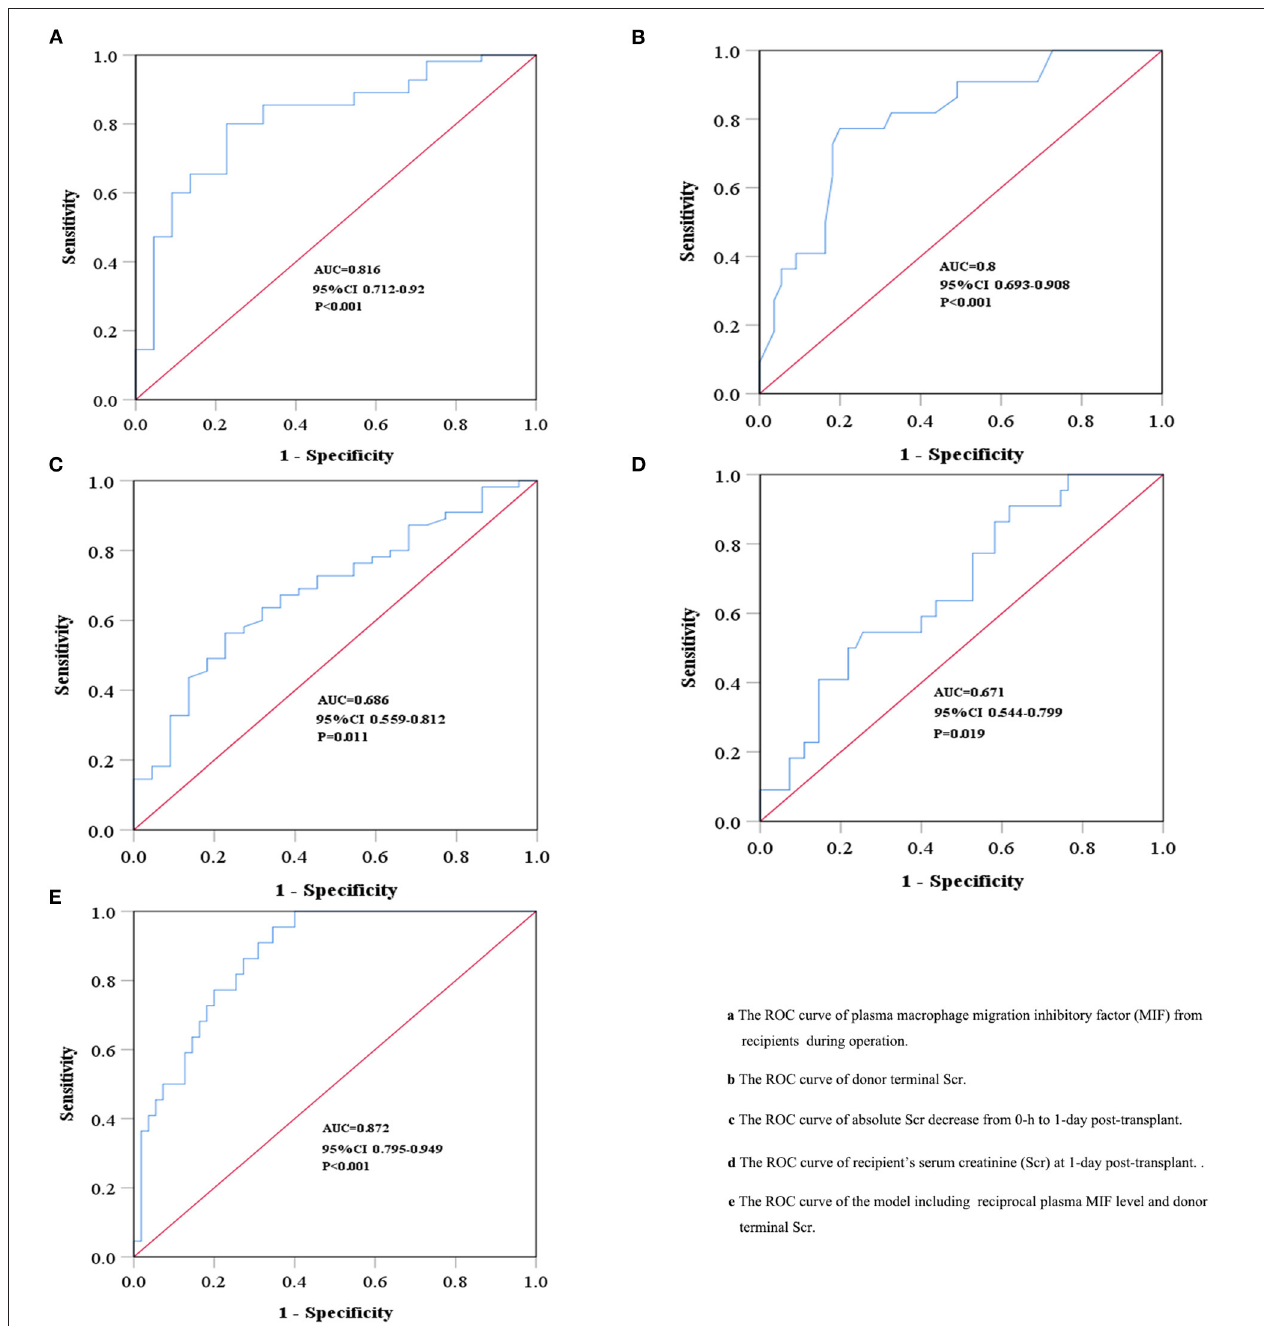
FIGURE 3 | Receiver operating characteristic (ROC) curves for recipient and donor characteristics for predicting delayed graft function. The ROC curves of plasma macrophage migration inhibitory factor (MIF) from recipients during operation (A) , donor terminal Scr (B) , absolute Scr decrease from 0-h to 1-day post-transplant (C) , and recipient’s serum creatinine (Scr) at 1-day post-transplant (D) . The linear prediction model including the reciprocal plasma MIF level and donor terminal Scr (E) .